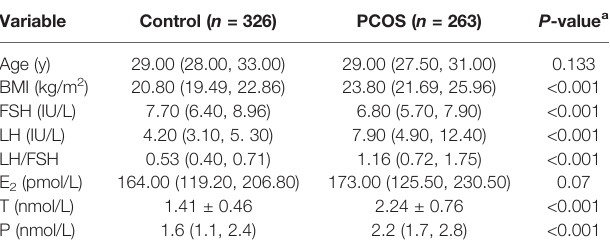
TABLE 1 | Clinical characteristics of women with PCOS and control subjects.